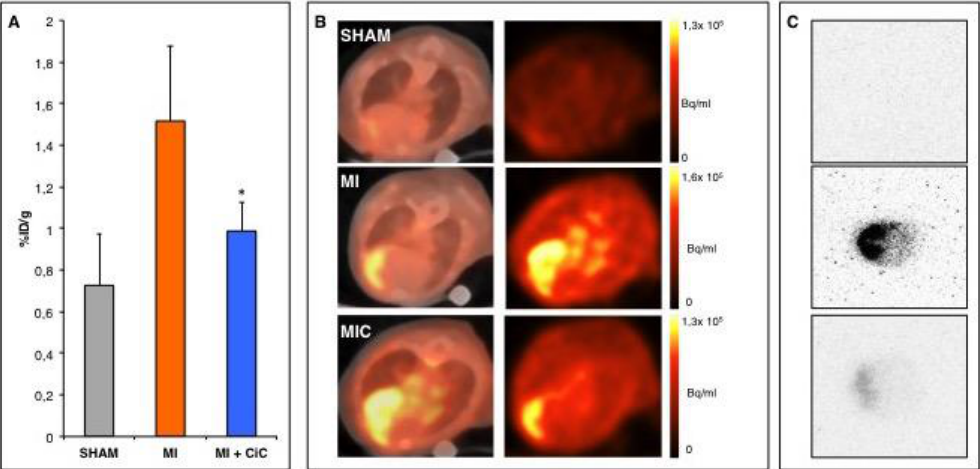
Figure 7. ( A ) Transplantation of CiC significantly reduces uptake of [ 68 Ga]-NODAGA-RDG in the infarct region. * p < 0.05 compared to the MI group. ( B ) Representative axial images of the respective group: PET/CT fusion images on the left, PET images on the right. Tracer accumulation can be clearly allocated to the infarct region. ( C ) Focal tracer accumulation is located in the infarct region as shown in representative images from autoradiography.